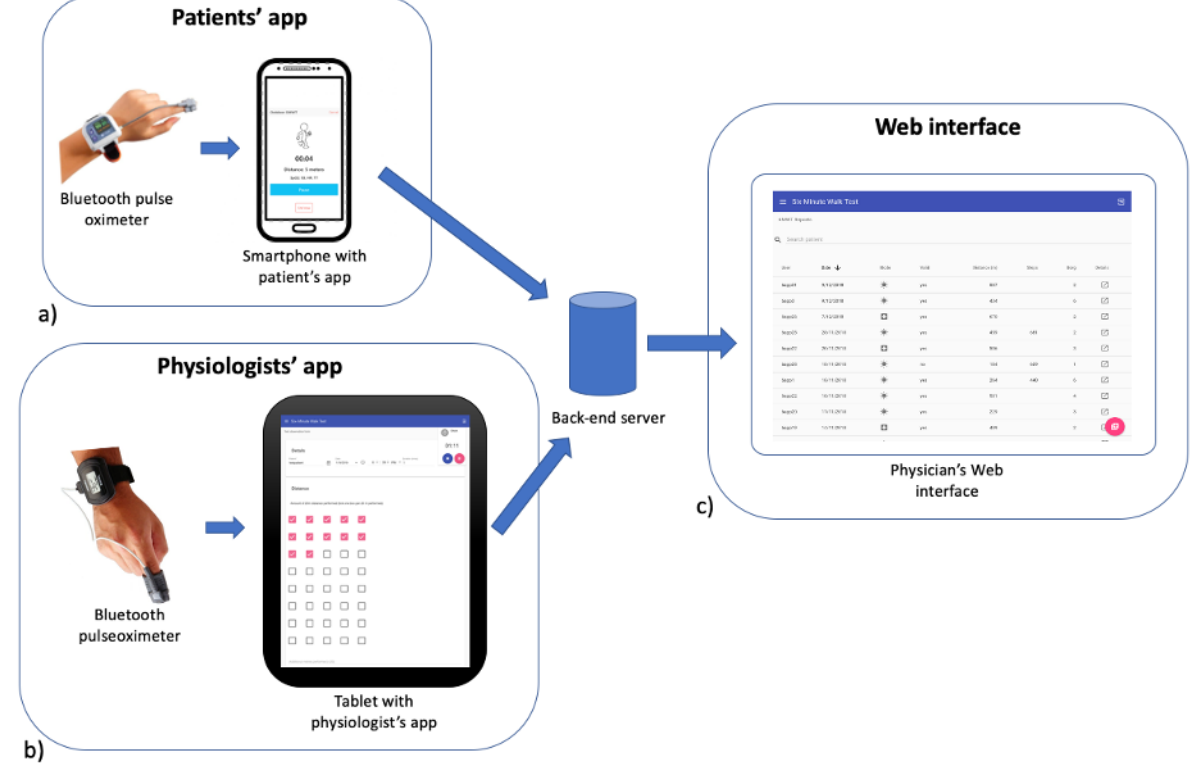
Figure 1. Architecture of the SMWT system: (a) patients’app, (b) physiologists’app, and (c) web interface for